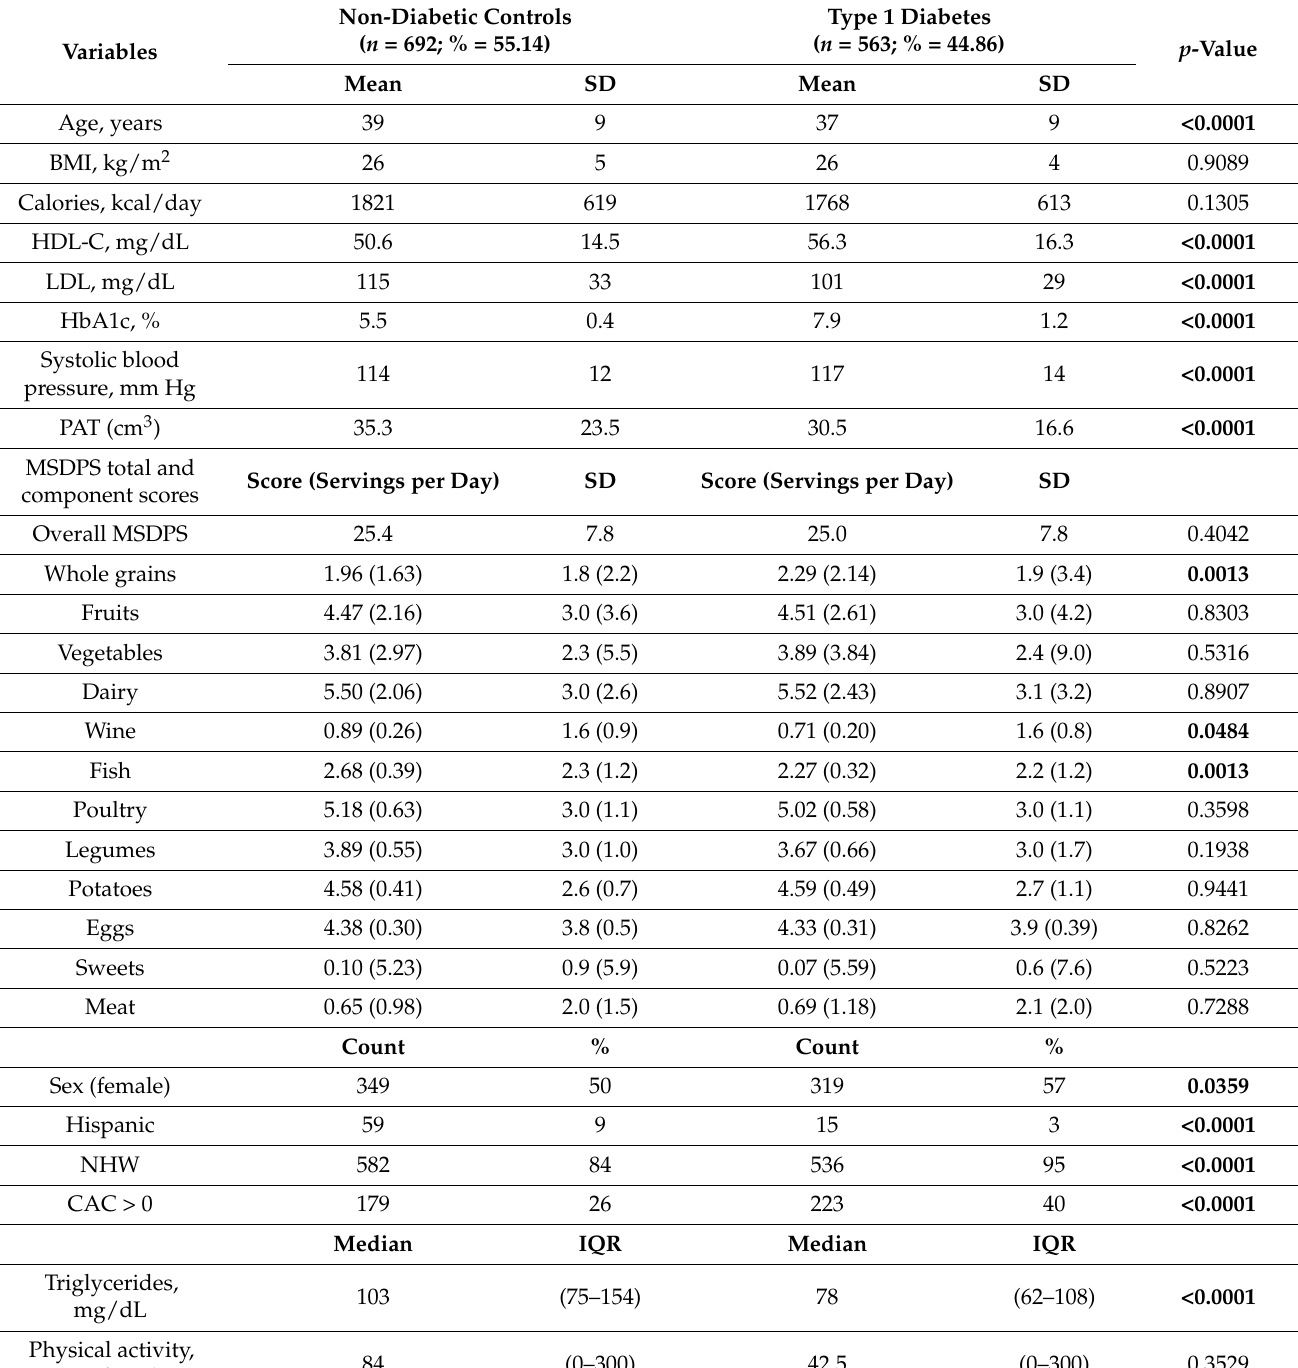
Table 1. Baseline characteristics of